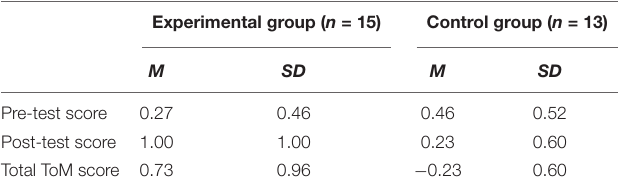
TABLE 2 | Descriptive data of experimental group and control group at pre-test, post-test, and total ToM